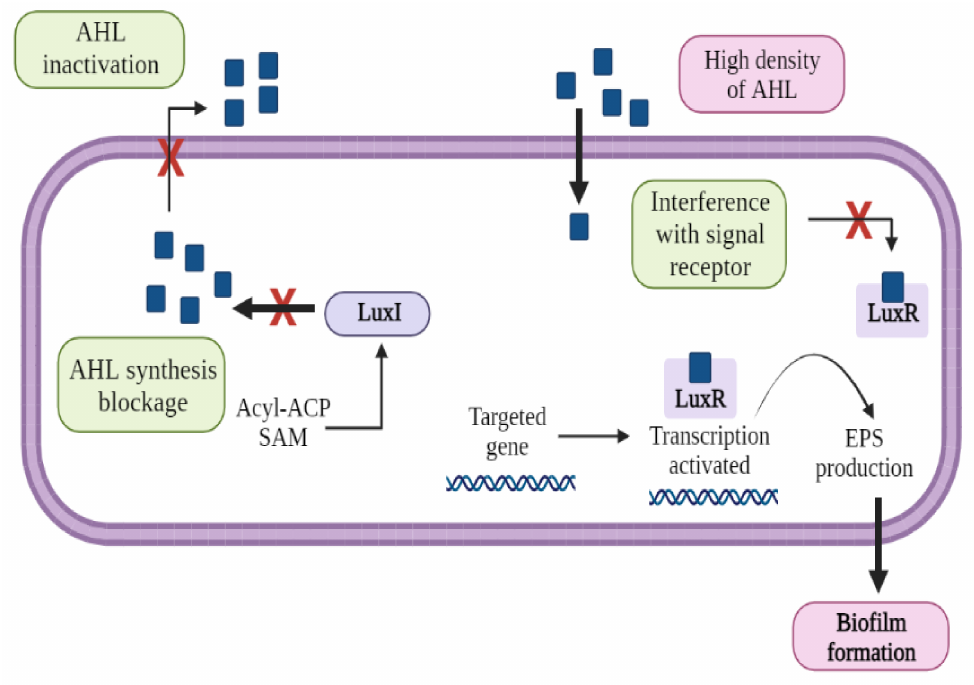
Figure 4. AHL degradation pathways. (1) AHL synthesis blockage, (2) AHL inactivation, (3) interfer- ence with AHL signal